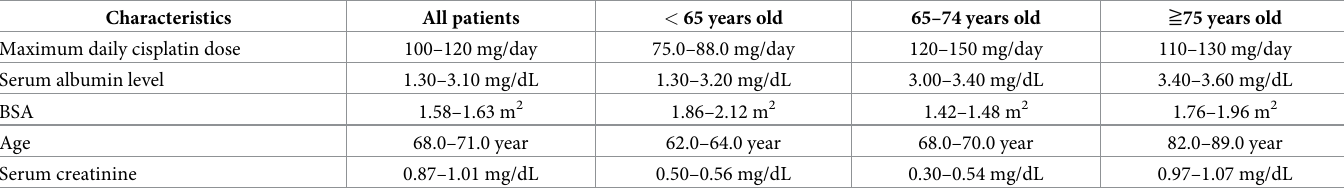
ment decreases the risk of nephrotoxicity better than cyclic high-dose cisplatin treatment [28]. Our result agrees with those of a previous report and suggests that daily dose reduction of cis- Cis-AKI in patients who aged 65–74 years old. BSA was identified as a risk factor of Cis-AKI from hypoalbuminemia and aging, the evaluation of association among these factors is needed to validate our results. In the current prediction model, the baseline serum creatinine level was not recognized as a useful predictor of Cis-AKI. Since monitoring of serum creatinine did not improve mortality and the introduction of renal replacement therapy in patients with AKI [14], our result par- tially agreed with the results of a previous study. Liver-type fatty acid-binding protein, urinary kidney injury molecule-1, tissue inhibitor of metalloprotease-2, and neutrophil gelatinase-